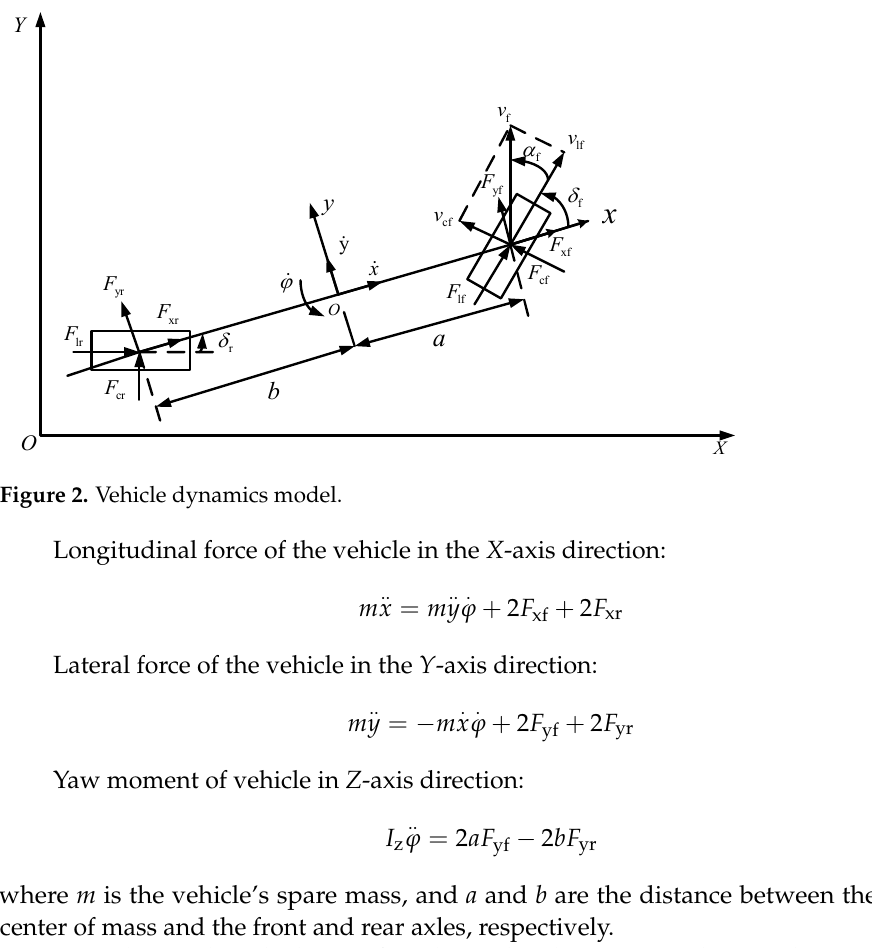
Yaw moment of vehicle in Z -axis direction: